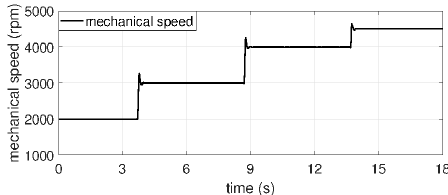
Figure 5. Torque at ( a ) no-load and ( b ) load.